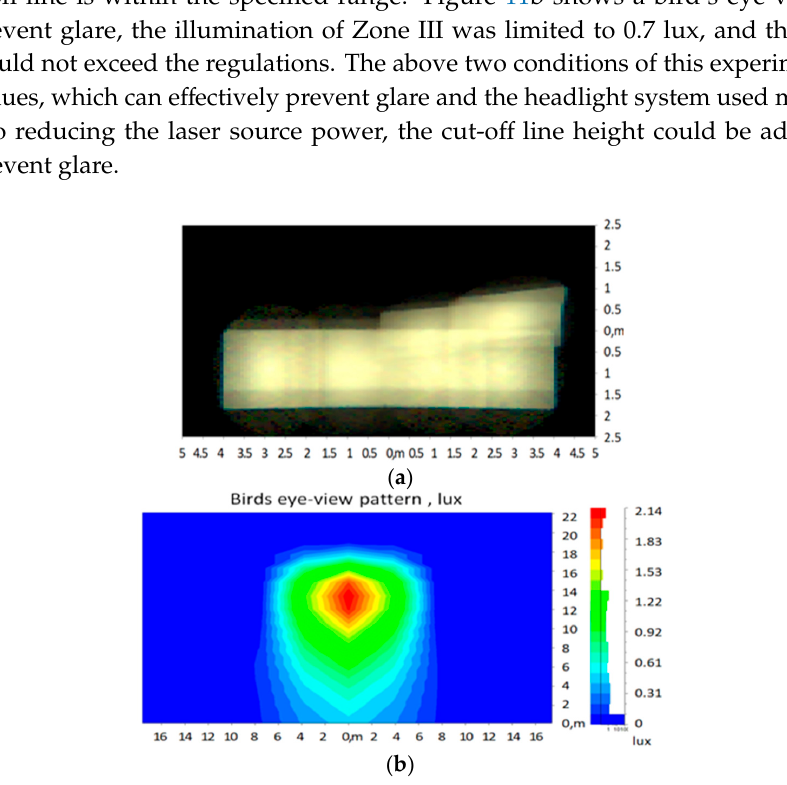
Figure 11. ( a ) Illumination simulation results from LightTools, ( b ) simulation results of bird’s eye view pattern from LightTools.